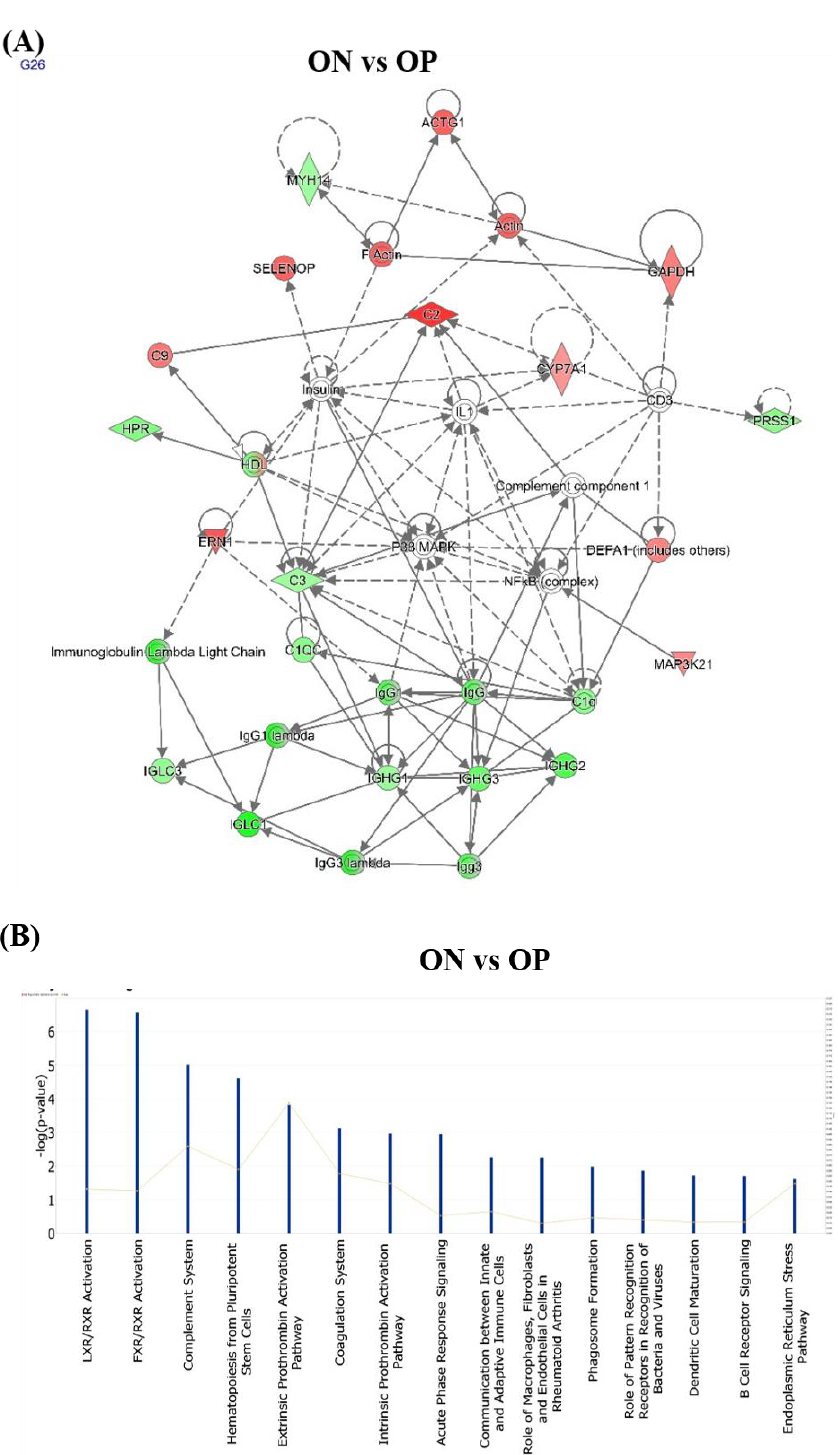
Figure 6. Network analysis and biological pathways related to the significantly identified proteins in the study population. ( A ) Network pathway analysis of the significantly dysregulated proteins identified in the ON group, compared to those in the OP group revealed that they were related to the developmental disorder, hereditary disorder, and metabolic disease. The analysis also showed the involvement of the TNF and IFNG signaling pathways. ( B ) The top canonical pathways related to the significantly dysregulated proteins identified in the ON group, compared to those in the OP group.